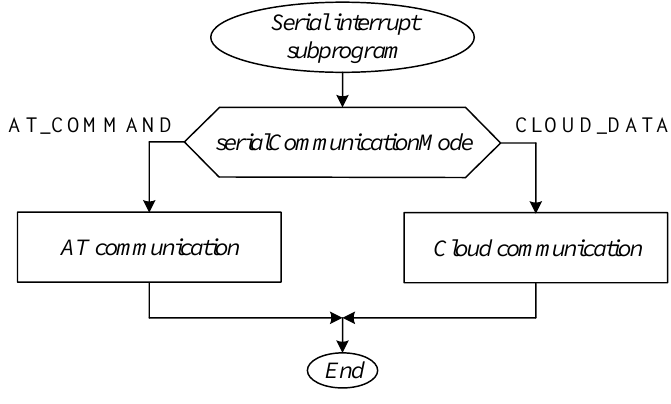
Figure 9. Serial interrupt subprogram.